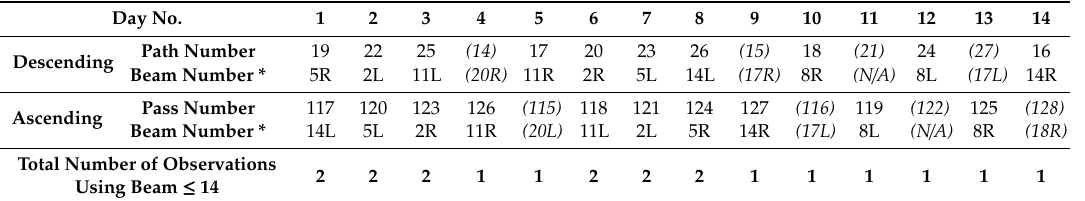
* L: Left-looking, R: Right-looking, N / A: not observable because the target area is on the nadir direction.